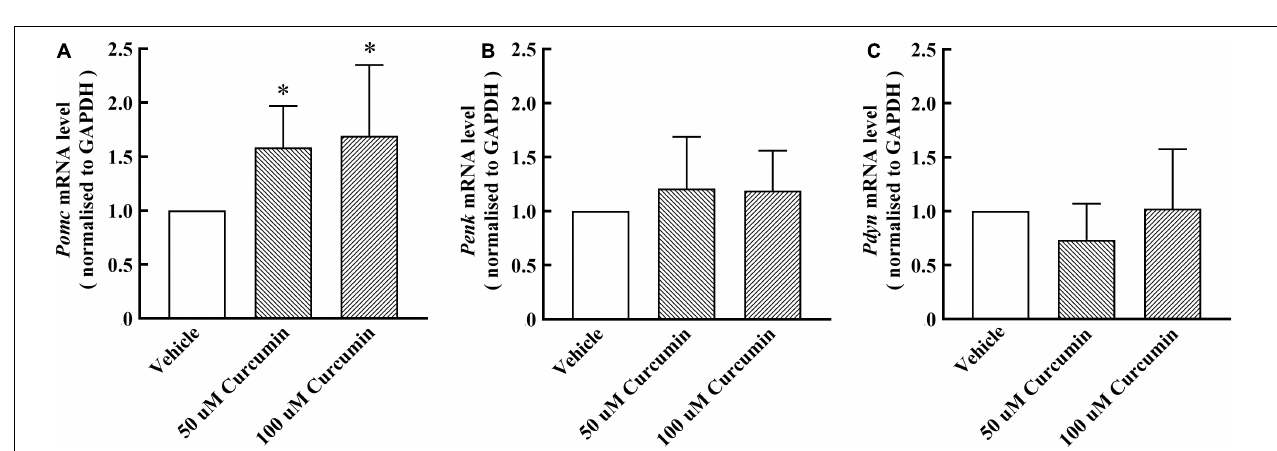
FIGURE 3 | Effect of curcumin on the mRNA levels of endogenous opioid peptides in primary DRG neurons. The cells were collected 6 h after curcumin or vehicle incubation with primary cells, and the expression of Pomc , Penk , and Pdyn was evaluated by using RT-PCR. Both 50 and 100 µ M curcumin significantly increased the level of Pomc mRNA (A) in rat DRG neurons, but had no significant effect on Penk and Pdyn mRNA (B,C) . Data are shown as means ± SEM, n = 5–6. * P < 0.05 compared with the vehicle group, t -test.